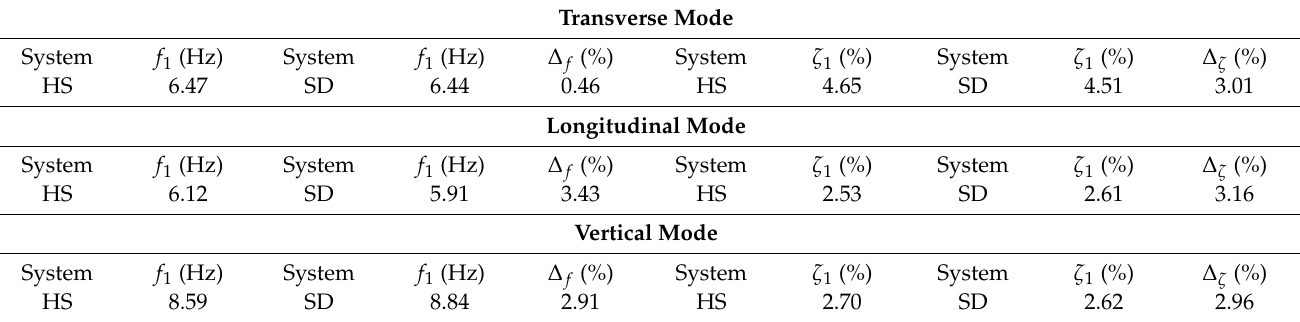
Table 9. Building fundamental frequency f 1 , and damping, ζ 1 , with their differences, ∆ f and ∆ ζ , as measured by two- vision